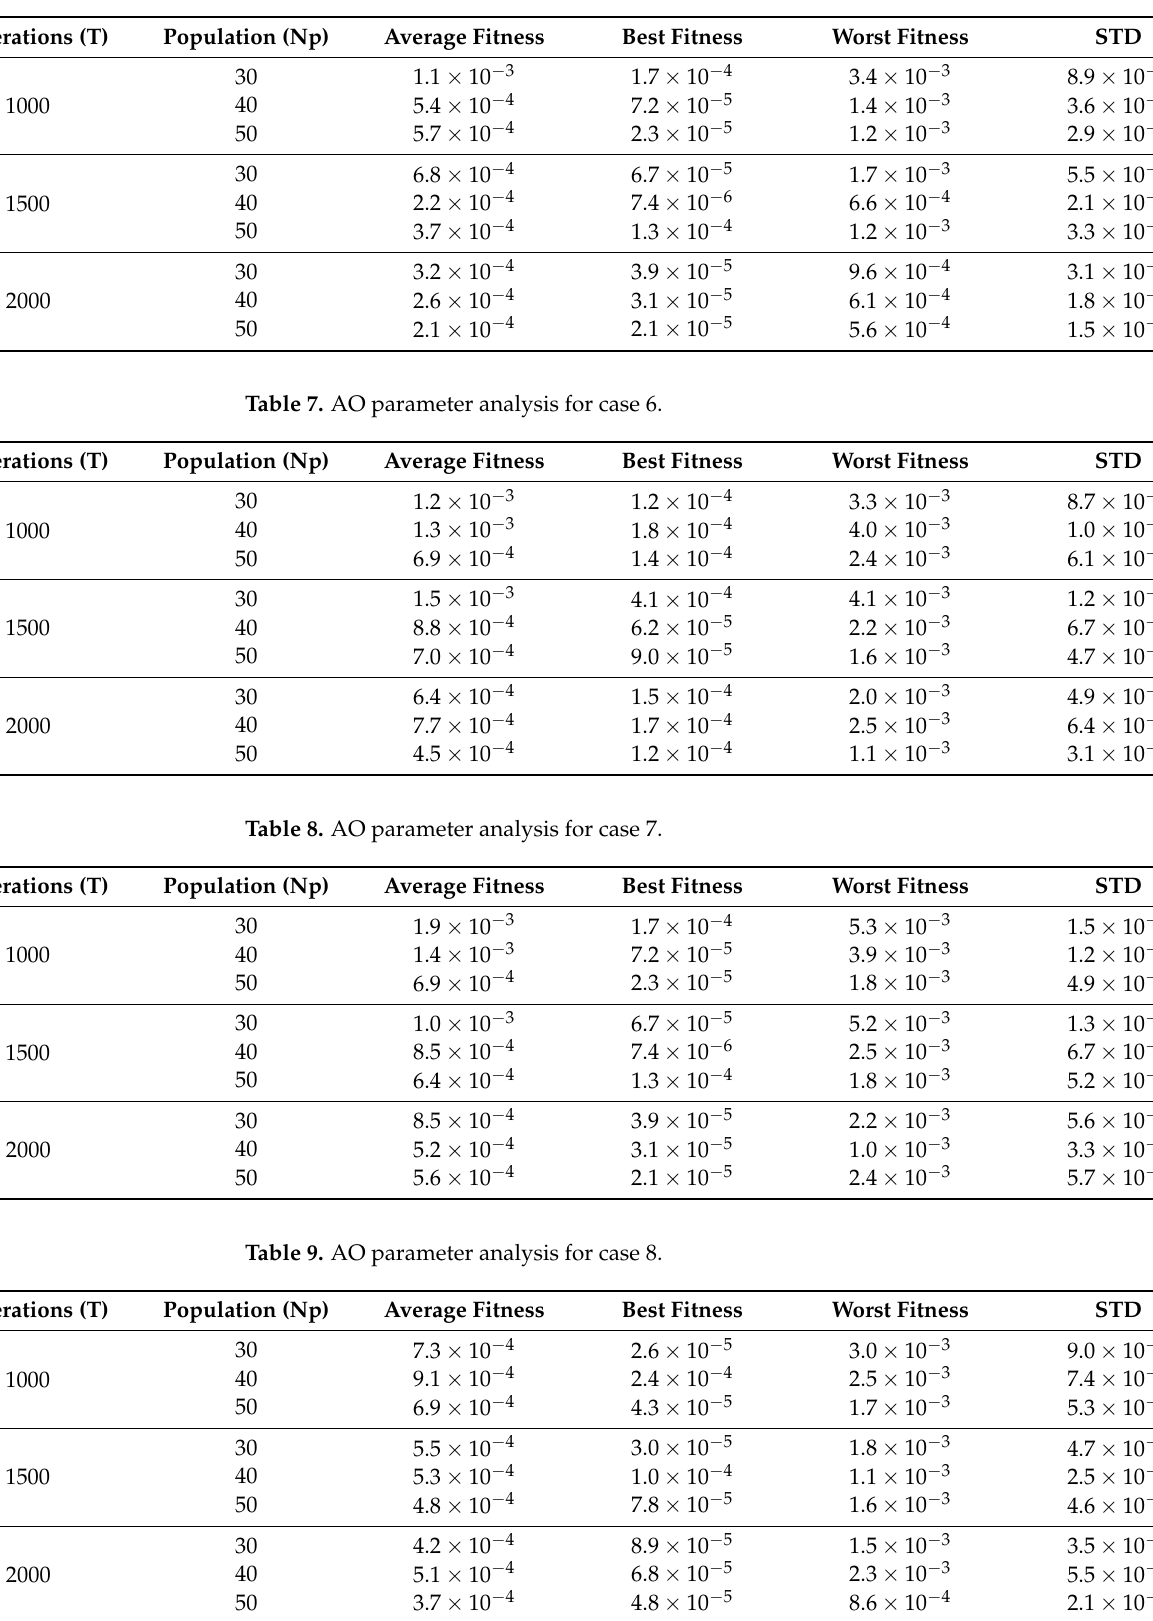
Table 6. AO parameter analysis for case 5.